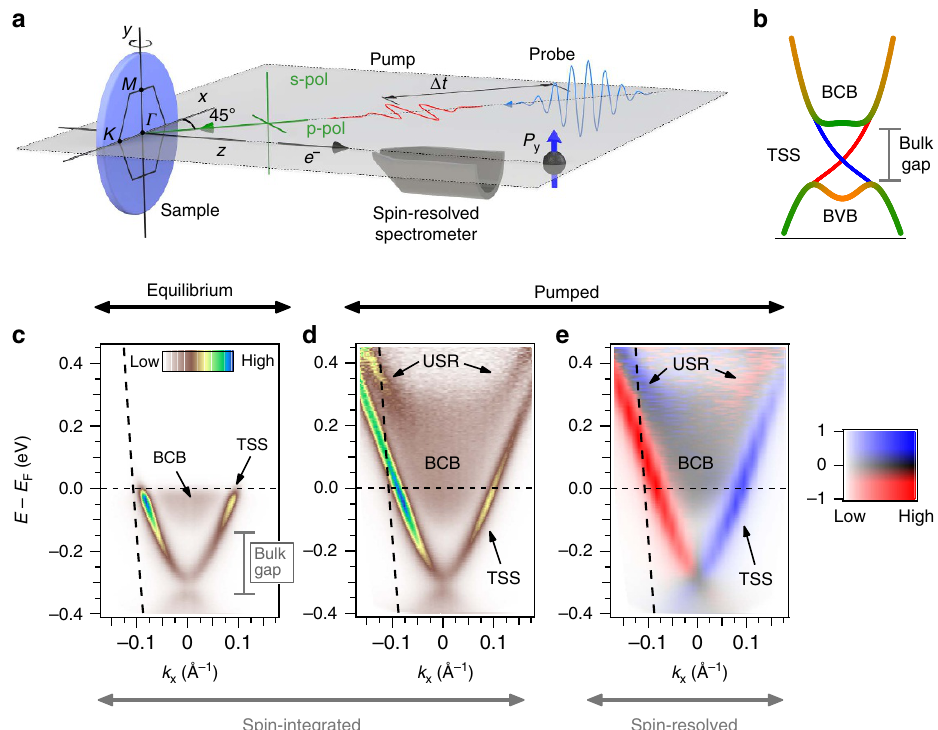
Figure 1 | Spin resolved electronic structure of Bi 2 Se 3 below and above the Fermi level. ( a ) Experimental geometry of the spin, time, and angle-resolved photoemission measurement. 1.5eV pump and 6eV probe pulses are incident on the sample with relative time delay D t . Unless otherwise specified, the pump is p -polarized and the probe is s -polarized. The orientation of the crystal axes with respect to the pulses and spin-resolved spectrometer is as depicted for data taken along G -K. Angle-resolved spectra are obtained by rotating the sample with respect to the y -axis. ( b ) A naive expectation for the electronic structure of the topological surface state (TSS) formed by spin-orbit-induced band inversion. The characteristic M-shape of the bulk valence band (BVB) is a signature of its hybridization with the bulk conduction band (BCB) driven by band inversion. The TSS exists within the bulk gap, within the band inversion region. ( c ) Equilibrium (no pump) spectrum taken along G -K in spin-integrated mode. The colorscale represents photoemission intensity. ( d ) Same spectrum, but with pump, at a time delay D t ¼ 0.7ps. Here, the spectrum is also divided by the effective Fermi-Dirac distribution ( k B T ¼ 85meV) of the pumped spectrum to allow the resolved features through the wide intensity dynamic range of the spectrum to be visible in a single color scale. The continuation of the TSS above the bulk band gap is well resolved. An increase in spectral weight toward the top of the BCB coincides with the unoccupied surface resonance (USR). ( e ) Spin-resolved map of the pumped spectrum, showing that the USR is spin-polarized in a direction opposite to that of the TSS. The spectrum is plotted with the two-dimensional colorscale shown, with the horizontal axis corresponding to intensity and the vertical axis corresponding to spin the positively polarized USR (blue). In Fig. 3c,d we extract the delay-dependent intensity and polarization of the TSS (above E F ) and the USR, integrating through the purple and green boxes, respectively, in panels (a) and (b). Despite the substantial increase of population due to pumping, the polarization within the purple box is constant for all delays, evidencing the robustness of the spin texture of the TSS. The behavior within the green box is precisely the same: despite substantial population changes, the polarization is constant within experimental error bars.